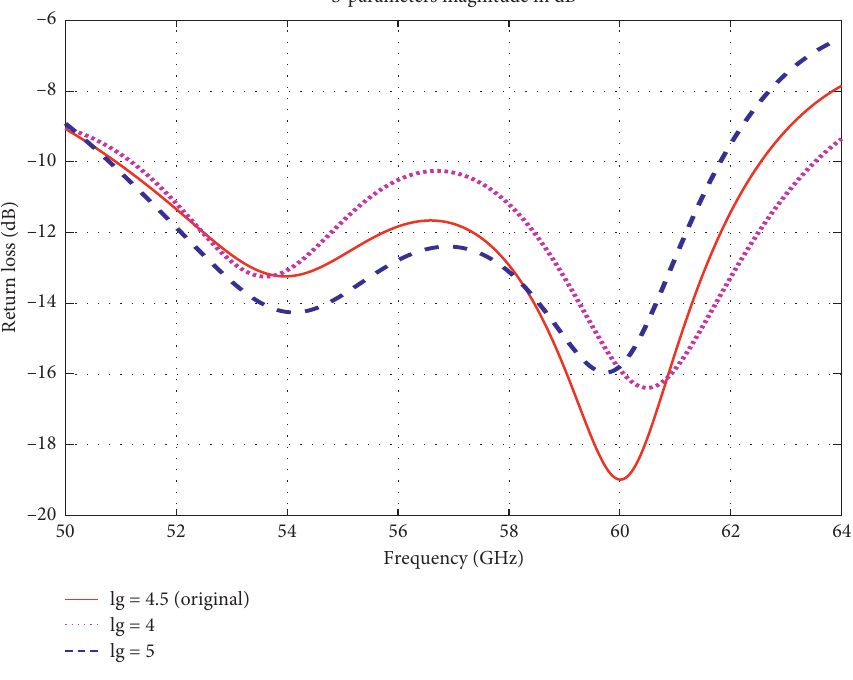
Figure 8: Return loss for change in ground length “lg.”